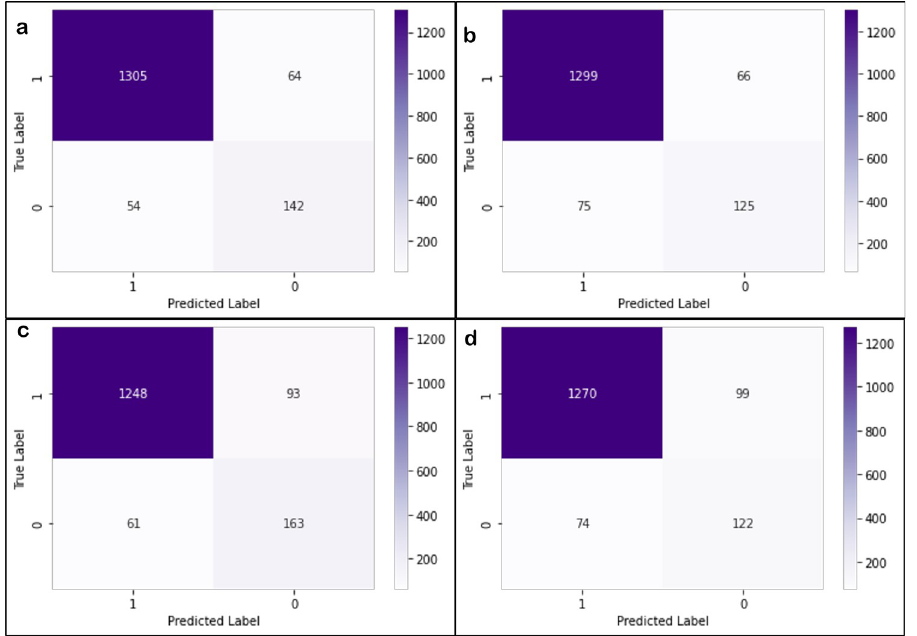
Fig 5. Confusion matrices for the prediction of knn model on the 22ROIs (a) and 26 ROIs(b) dataset. Confusion matrices for the prediction of random forest model on 22 ROIs (c) and 26 ROIs (d)